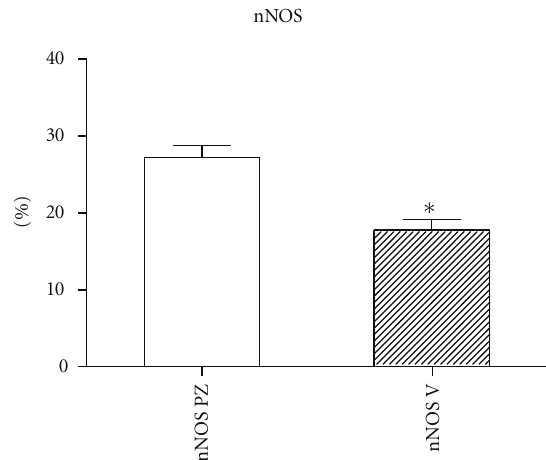
Figure 2: The graph of morphometric analysisresults of the expres- sionofnNOS in varicose and control groups of samples( P < . 0001).